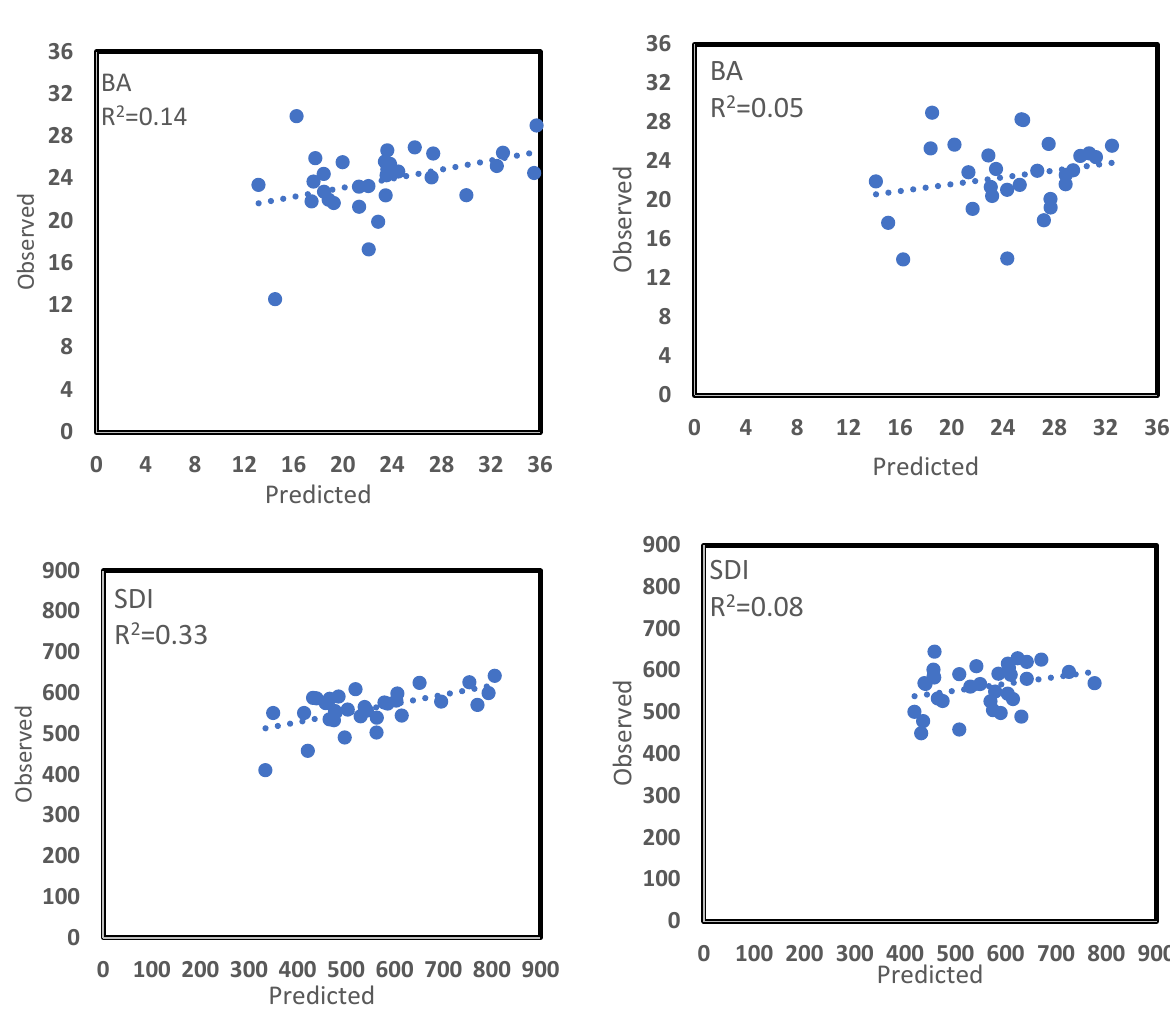
Figure 4. Relationships between observed and predicted values based on the independent test dataset of the 3rd cycle measurement: multiple linear regression models on left column and random forests models on the right column.